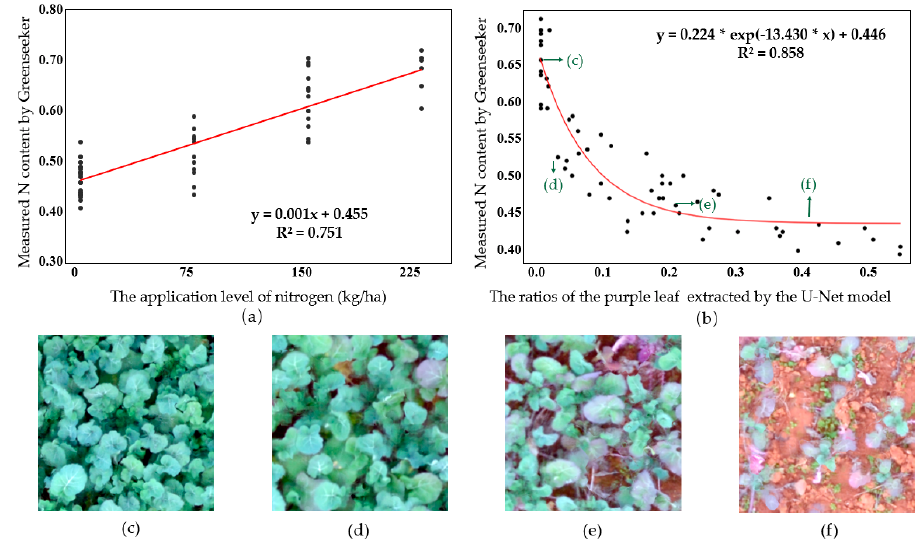
Figure 9. The results evaluation of N stress detected by the ratios of purple rapeseed leaves (purple leaf area to total leaf area). ( a ) Scatter plot and fitted curve between four N application level and N content measured by GS, ( b ) scatter plot and fitted curve between the ratios of purple rapeseed leaves extracted by the U-Net model and GS values, and ( c–f ) the images corresponded to the points in the ( b ).